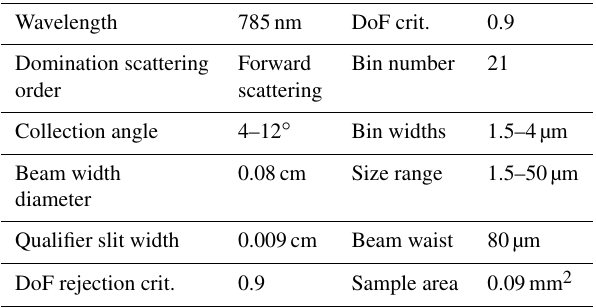
Table 2. Characteristic numbers of FCDP (serial no. 6) setup, SA and size calibration as of 28 April